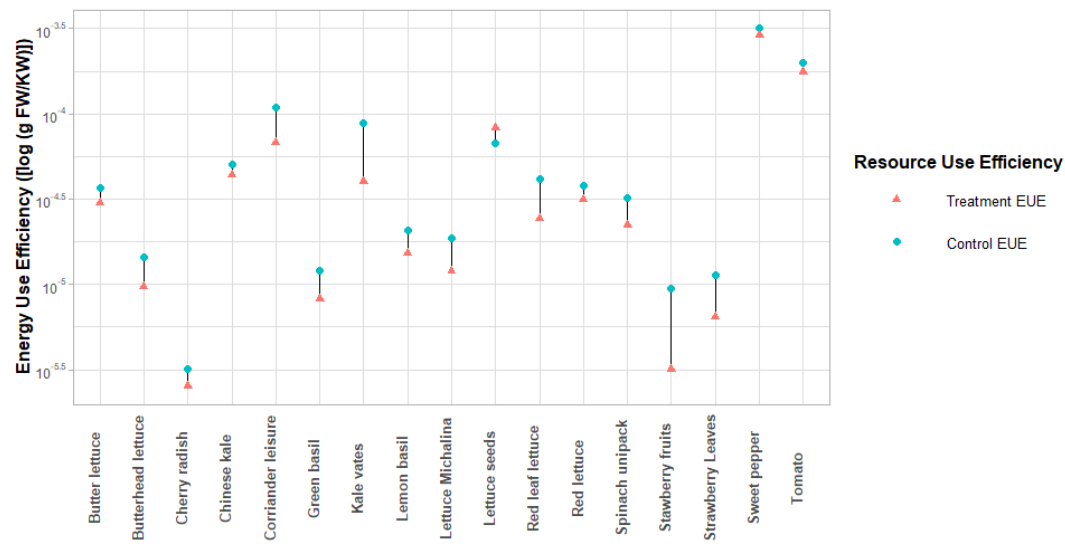
Figure 5. The energy use efficiencies (EUE) were calculated for vegetables and herbs grown in growth chambers, with (treatment) and without LED illumination (control) [15,44,57,84,109–111,119–121] .